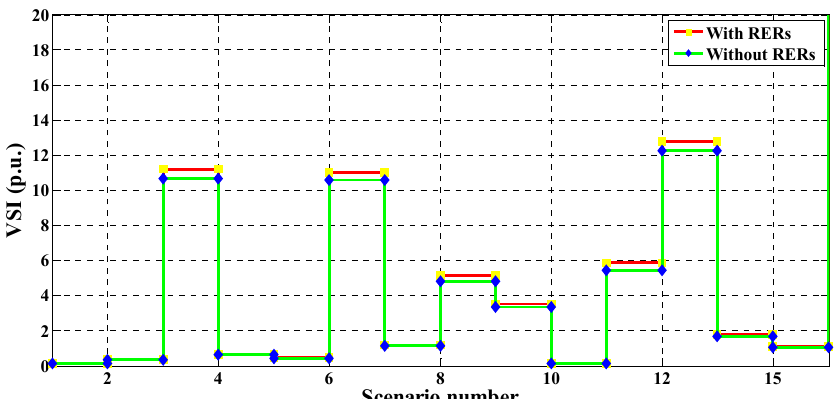
Figure 10. The IEEE 118-bus system VDs.